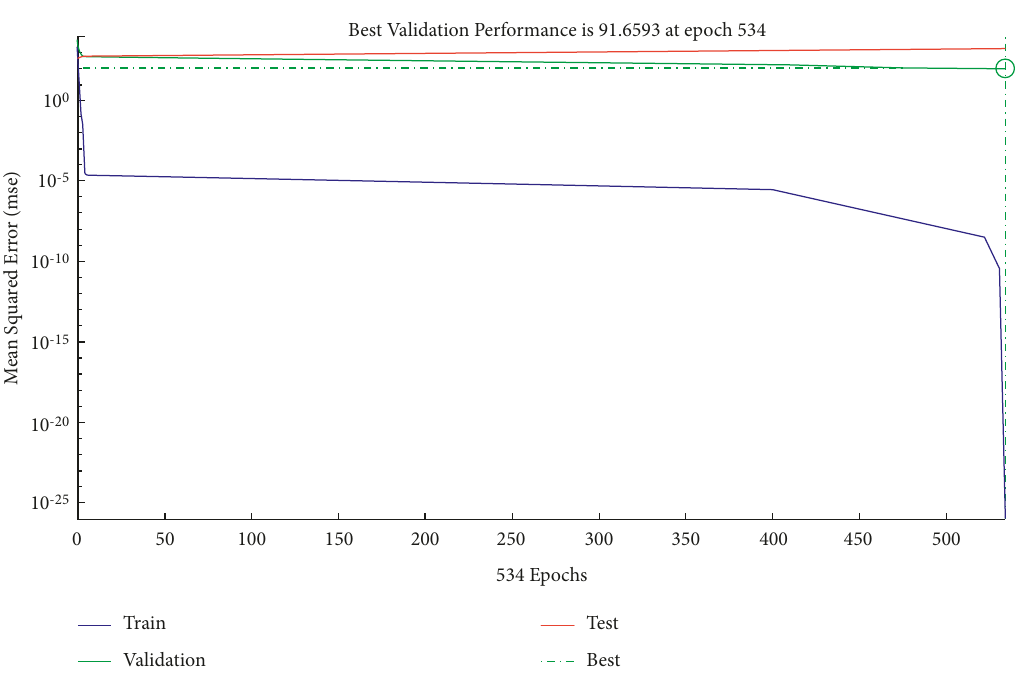
Figure 9: Performance plot of the training